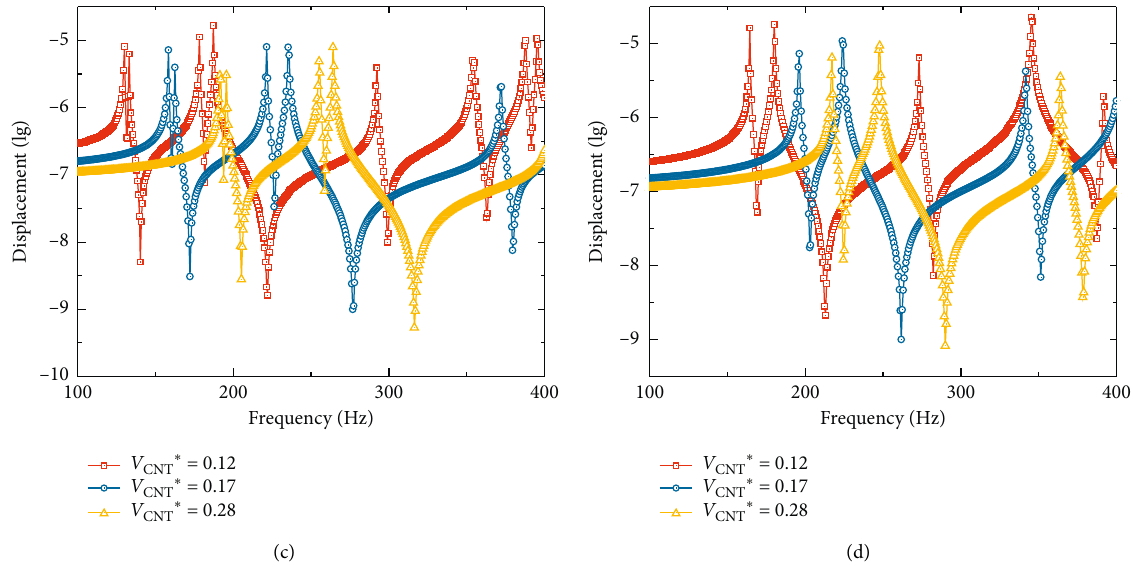
Figure 14: The frequency-displacement characteristics of multi-stepped FG-CNTRC plate under three types of V ∗ (c) CCFF. (d) E 1 E 1